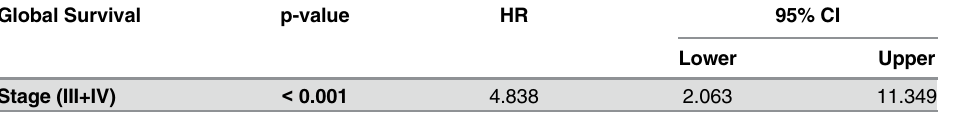
Table 10. Cox regression analysis using TNM stage as the independent variable and GS as the depen- dent variable. Global